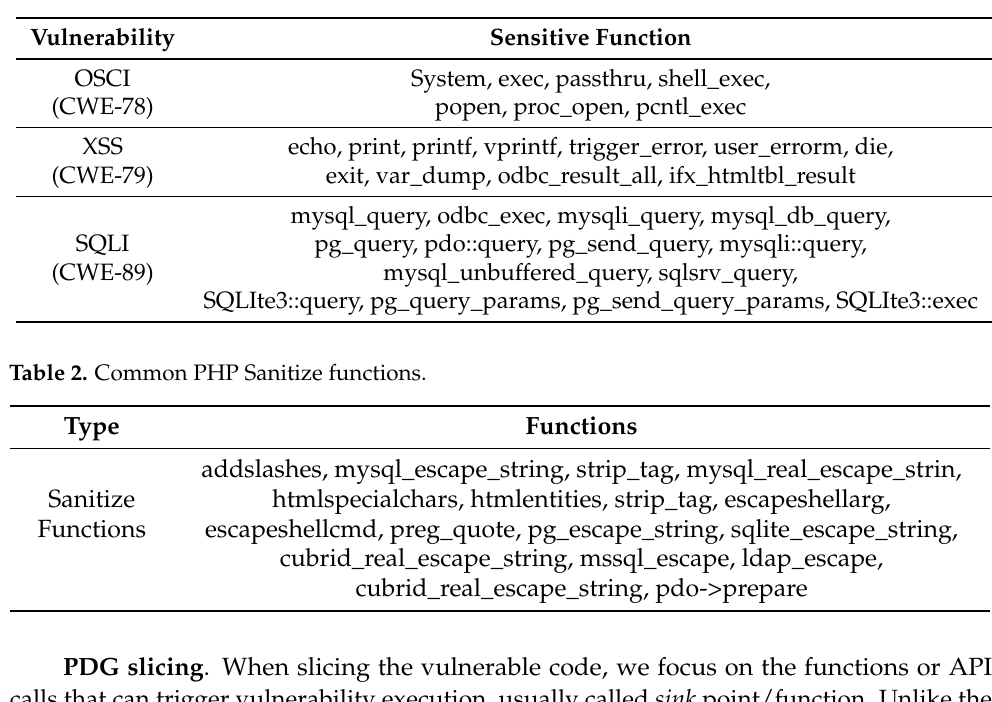
Table 1. Common PHP Sensitive API functions.